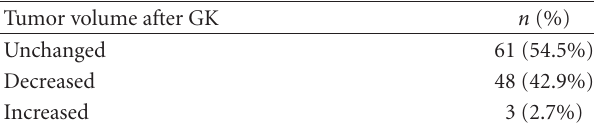
Table 3: Tumor growth control after GK